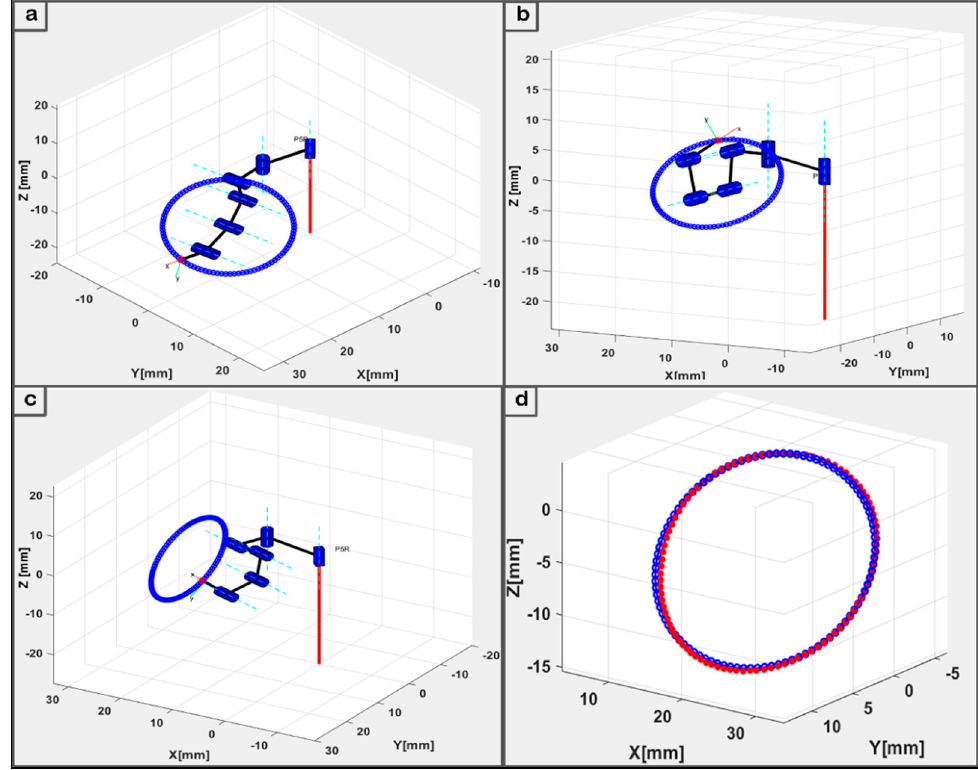
Figure 7. The IK results for the three case scenarios of a 3D circular path with n via-points: ( a ) description of n = 1; ( b ) description of n = 10; and ( c ) description of n = 20; and ( d ) Plot of actual and compute target points.